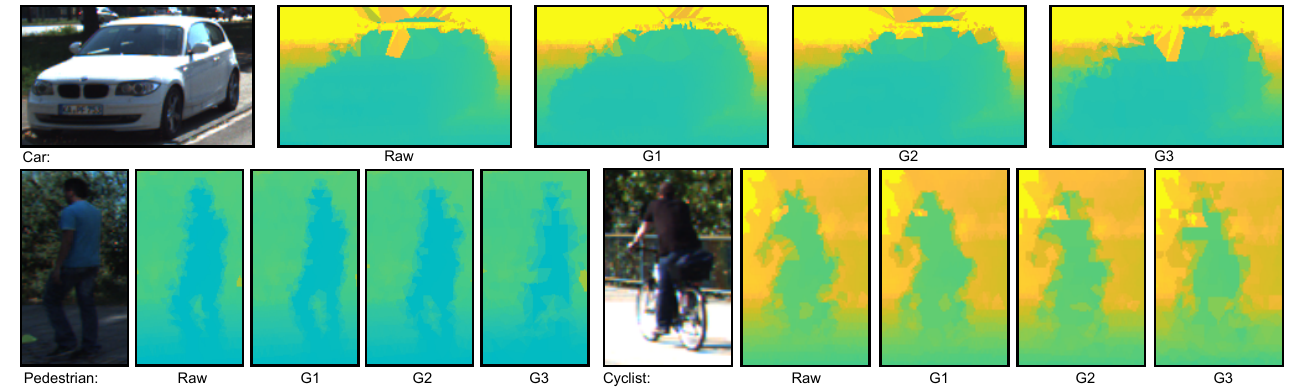
Figure 5. An example of the object classes that were considered from KITTI, with the depth images generated using the Delaunay Triangulation interpolation method from point clouds compressed at different degrees. For each object class, from left to right: RGB image, depth images computed from data at G1, G2 and G3 compression